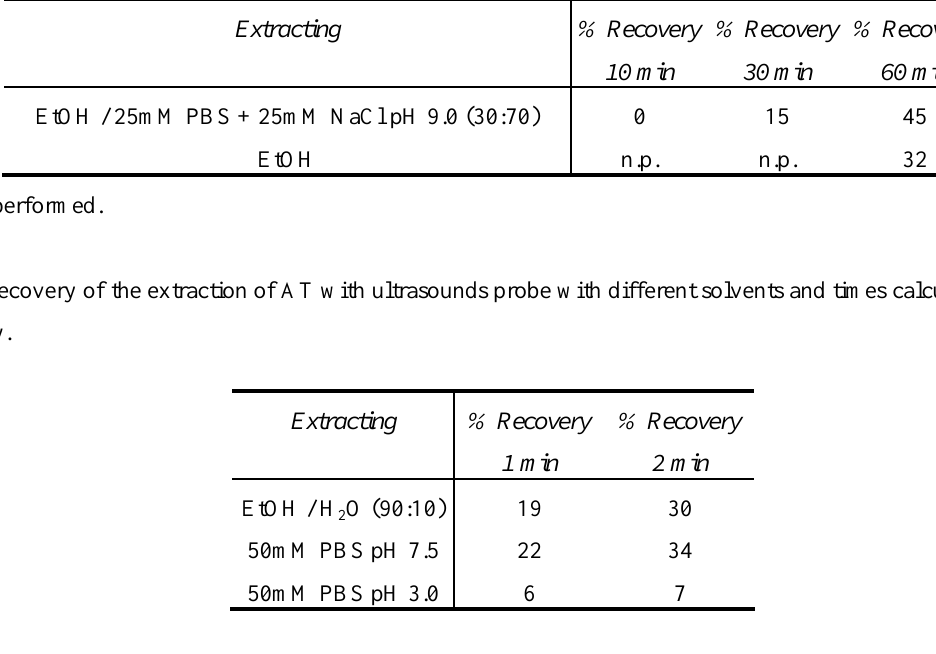
Table 4. % recovery of the extraction of AAC with ultrasounds probe with different solvents and times calculated trough UV